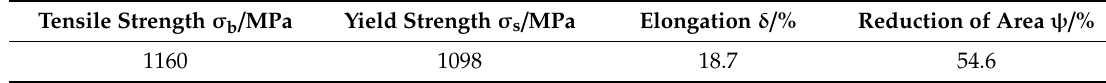
Table 2. Mechanical properties of 4340 steel.